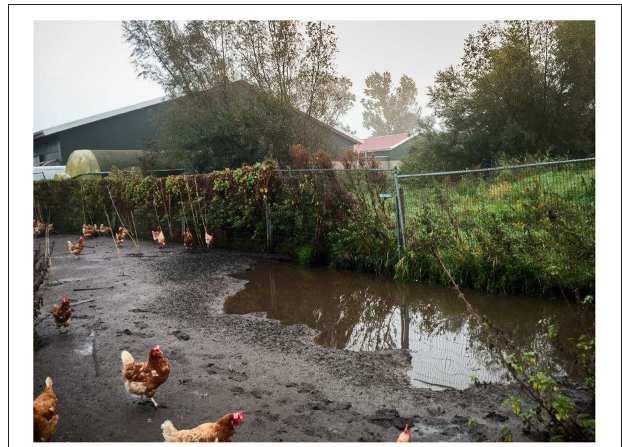
FIGURE 1 | Puddles were formed in the free-range area after severe and prolonged rainfall. Water samples were collected from these